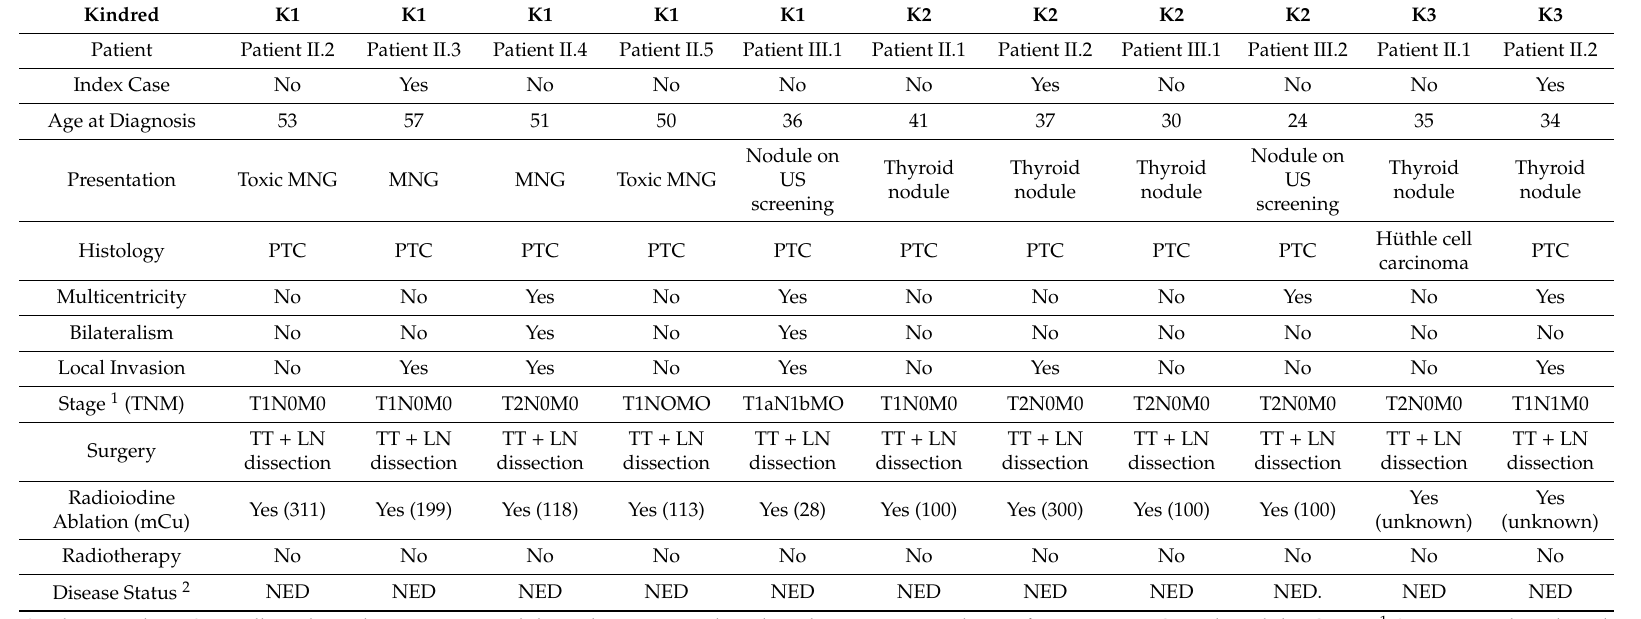
Table 2. Clinical characteristics, pathological findings, and treatment in familial non-medullary thyroid cancer (FNMTC) a ff ected members from Families 1, 2 and